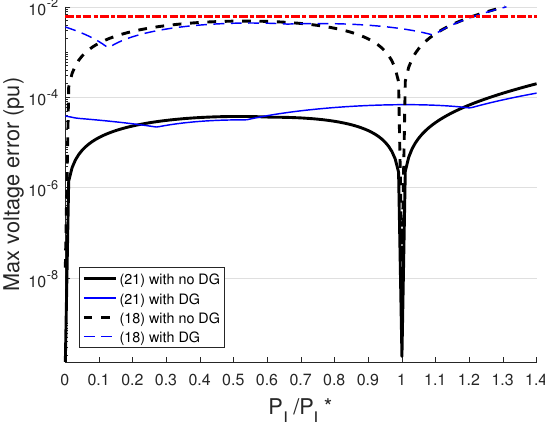
Figure 11. Small grid voltage error, for both the models of Equation (21) and of Equation (18), with S l =